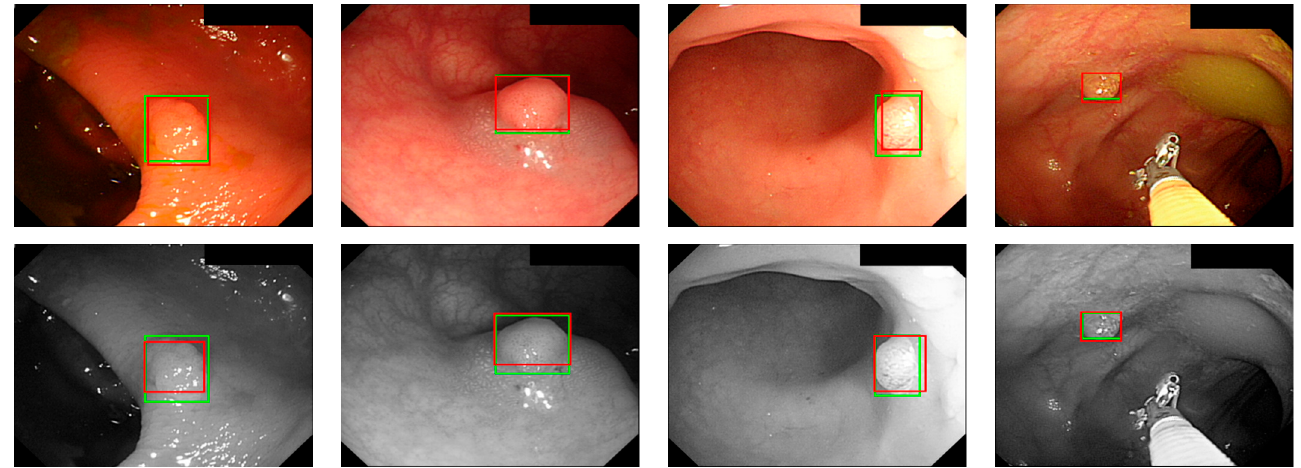
Figure 9. Colorectal polyp detection system architecture.